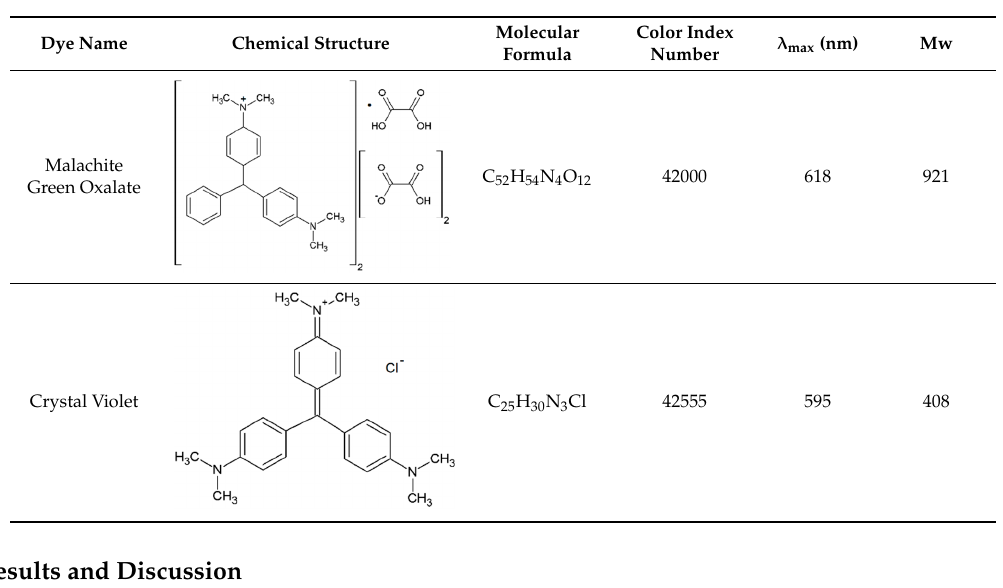
Table 1. Molecular structures of the malachite green and crystal violet dyes.